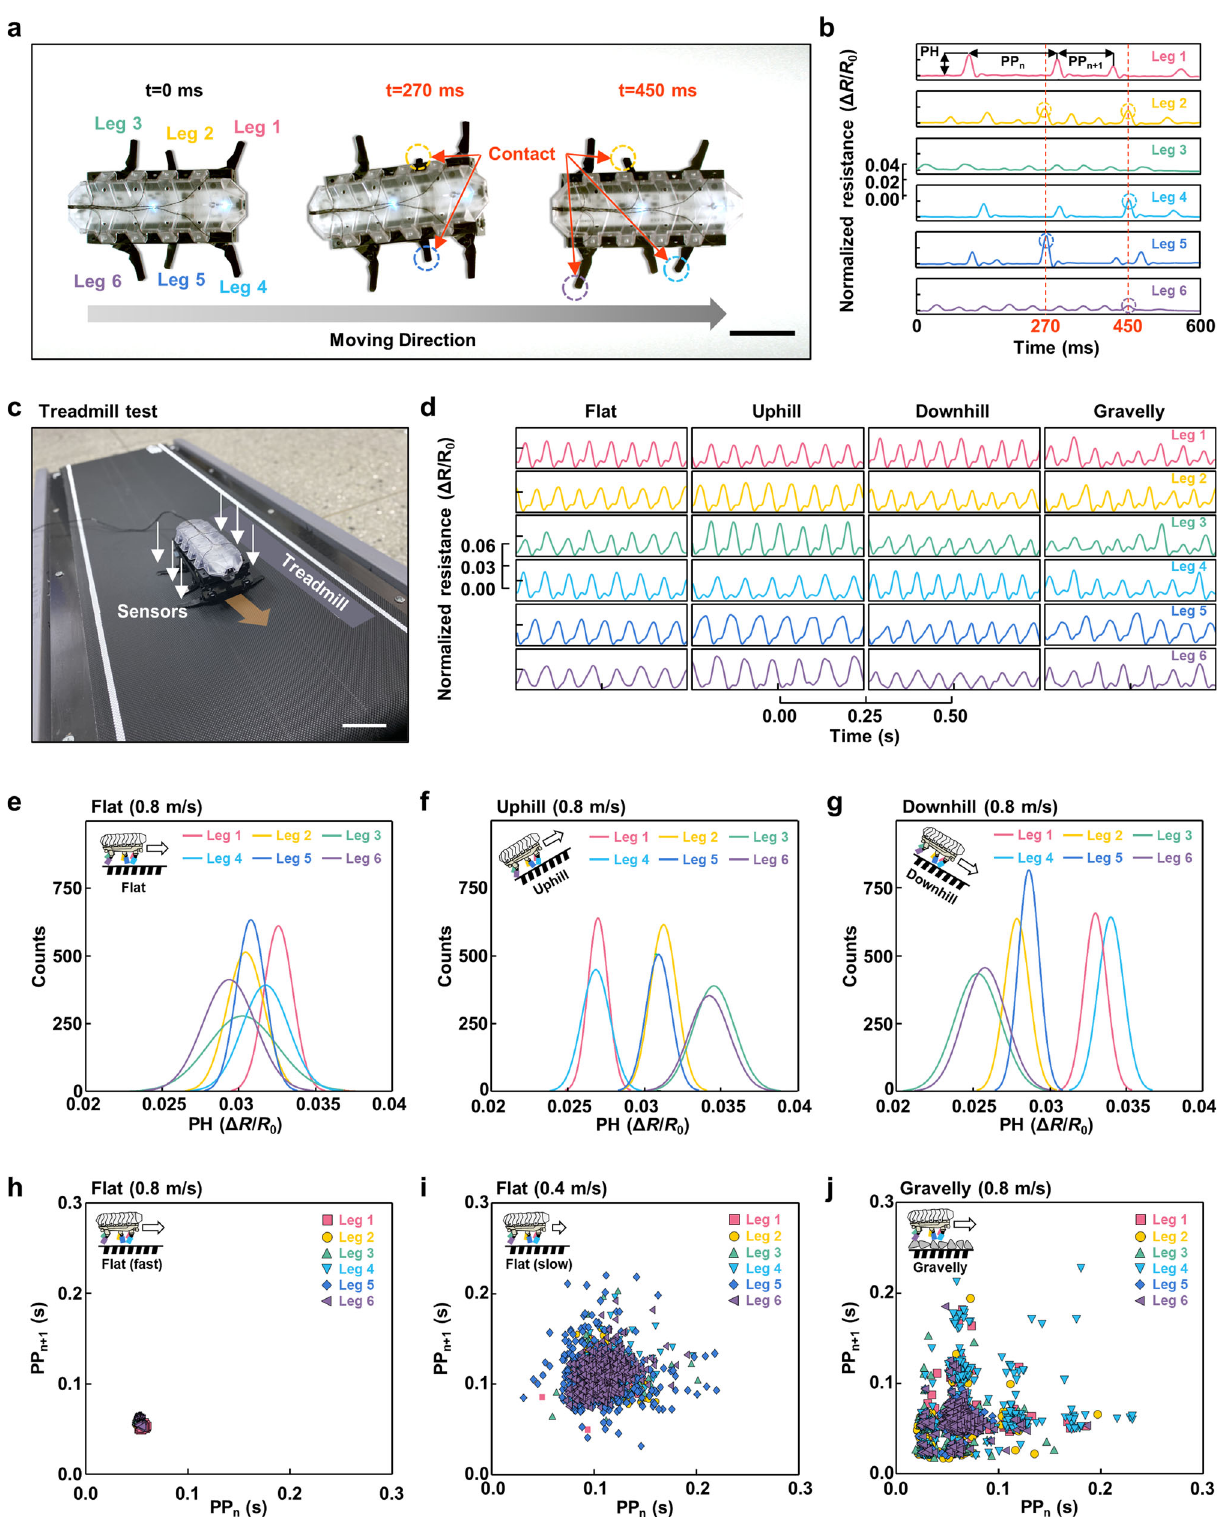
Fig. 4 Equipping the ULTIMAC on a bio-inspired legged robot: detection of terrain and analysis of gait. a Forward locomotion of the six- legged robot (Scale bar: 5 cm). b Sensor response of the robot running forward. c Long-term robot driving test setup using treadmill (Scale bar: 5 cm). d Normalized resistance changes of the sensor while robot running four terrains. ( fl at, uphill, downhill, gravelly). e – g Histograms of peak heights of the robot running fl at, 30° uphill, and 30° downhill. h Poincaré plot of peak-to-peak interval of the robot running on a fl at road at a speed of 0.8 m s − 1 . i Poincaré plot of peak-to-peak interval of the robot running on a fl at road at a speed of 0.4 m s − 1 . j Poincaré plot of peak-to-peak interval of the robot running on a gravelly road at a speed of 0.8 m s − 1